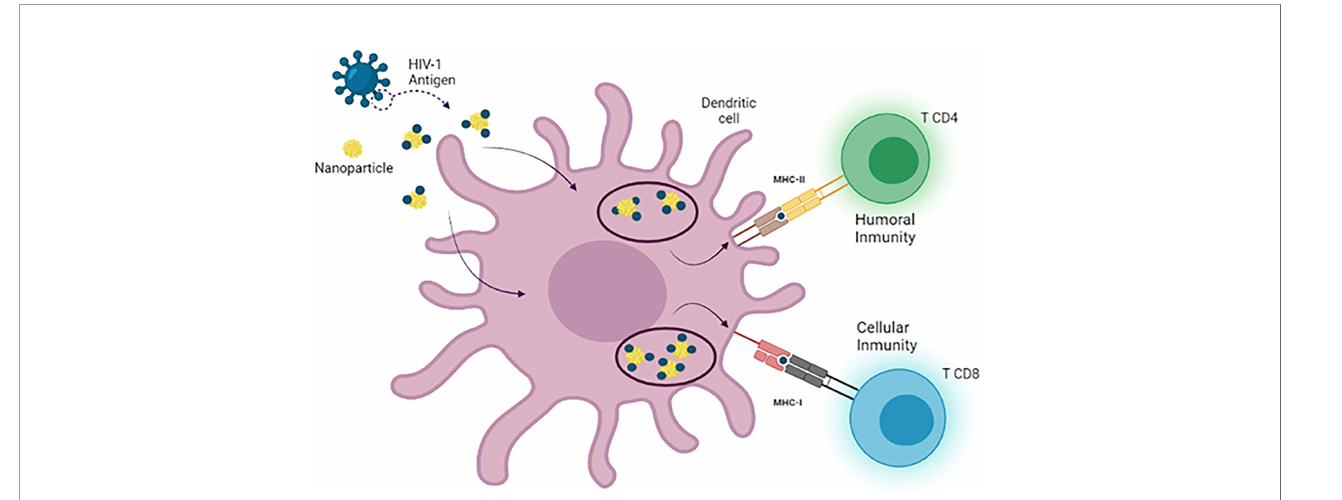
FIGURE 4 | Use of nanotechnology as a delivery system in dendritic cell vaccines. There are different types of nanoparticles that can be used as nanocarriers for antigen delivery in DC-based immunotherapies against HIV-1. During the development of these vaccines, MoDCs are loaded with antigen-nanoparticle complexes that enhance antigen uptake by DCs, leading to the generation of a more speci fi c and potent CD4+ T cell and CD8+ T cell response after reinjection of